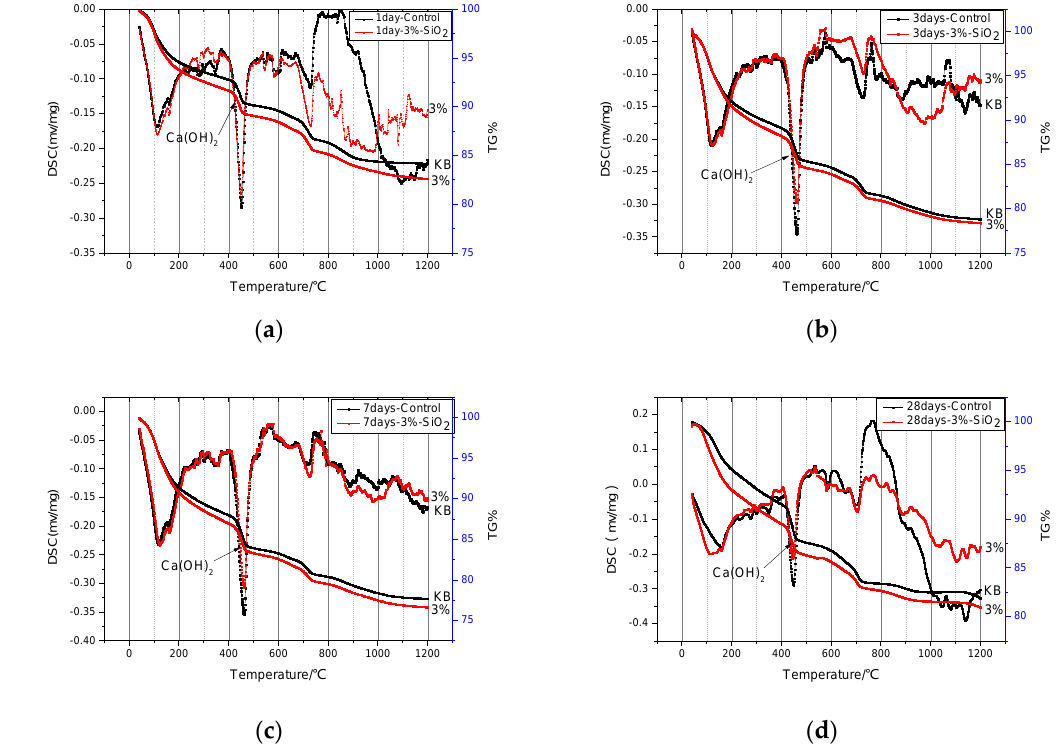
Figure 9. TG-DSC curves of cement pastes with 3% or without of nano-SiO 2 at different ages: ( a ) 1 day; ( b ) 3 days; ( c ) 7 days; and ( d ) 28 days.